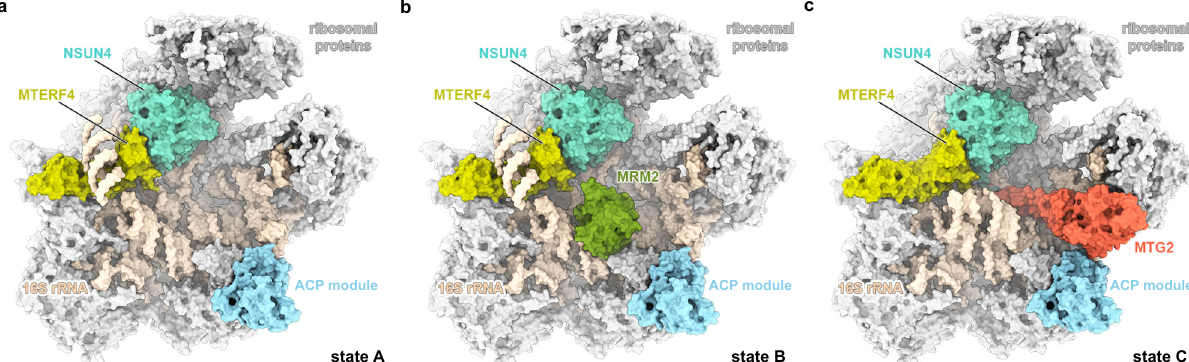
Fig. 1 Structures of the key human mitoribosomal large subunit assembly intermediates. The molecular structures of states A ( a ), B ( b ), and C ( c ) are shown in surface representation from the intersubunit side. Ribosomal proteins are depicted in light gray, 16S rRNA in beige, and assembly factors NSUN4, MTERF4, MRM2, MTG2, and the MALSU1 – L0R8F8 – mt-ACP (ACP) module in teal, light green, green, red, and blue,